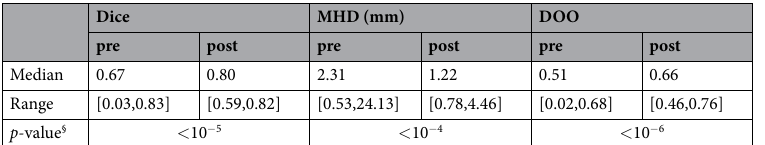
Table 1. Registration scores for pre- and post-elastic image registration. Abbreviations : MHD, Modified Housdorff Distance; DOO, Dose-Organ Overlap. § p -values express the significance of the interpatient match improvement at Wilcoxon signed rank